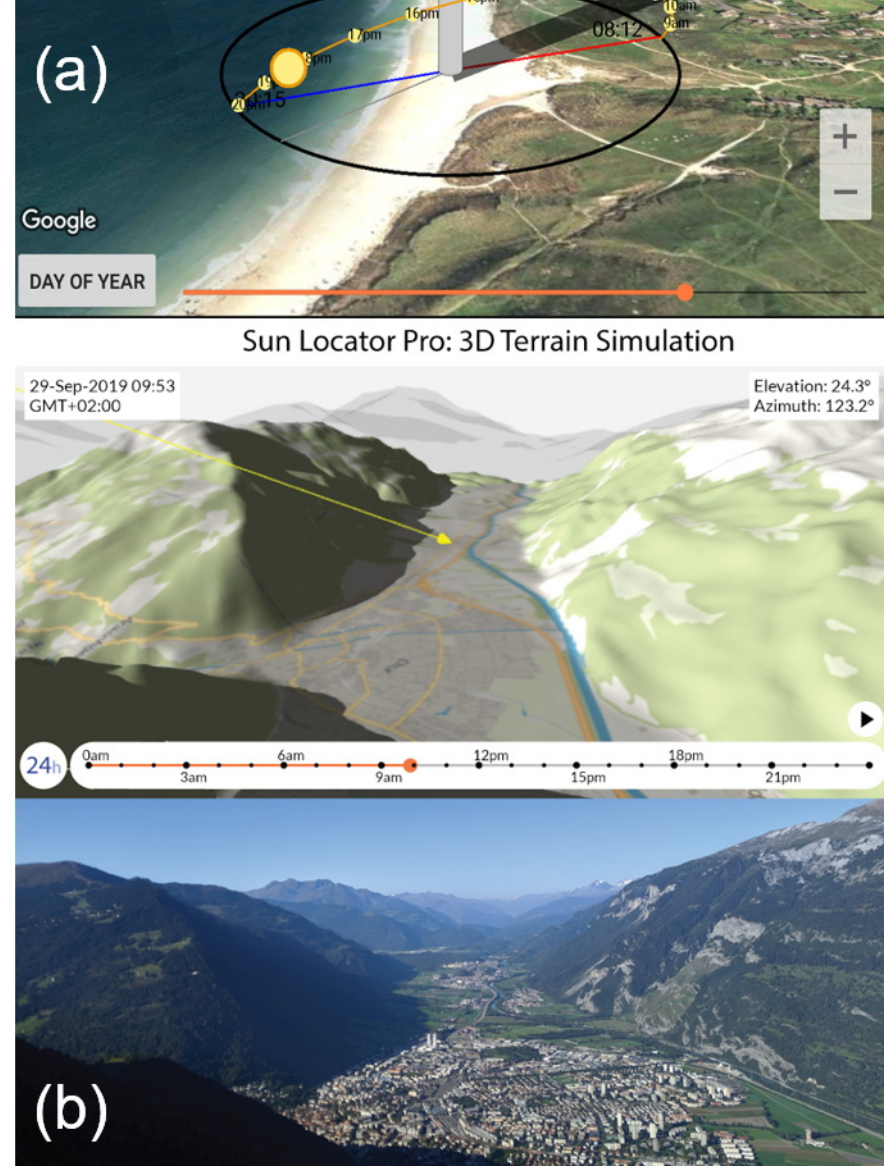
Figure 1. Representative smartphone application, Sun Locator Pro (Sun and Moon), for the sun’s location: ( a ) augmented reality (AR)-based visualization of the sun trajectory, ( b ) shade calculation [28].